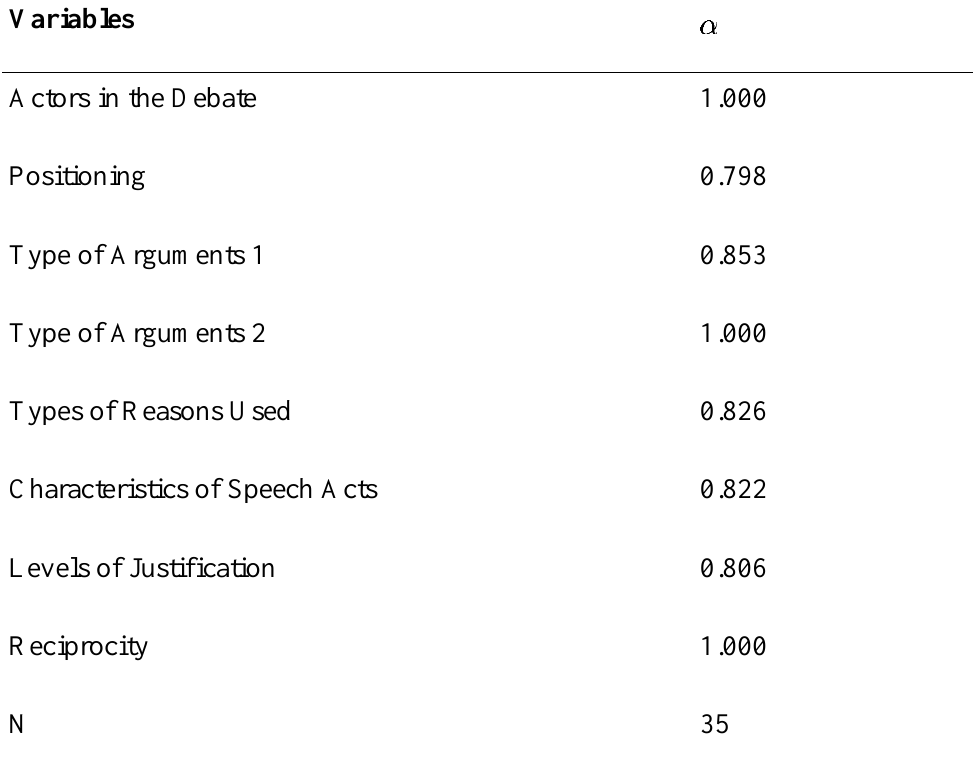
Table 1: Inter-coder reliability and